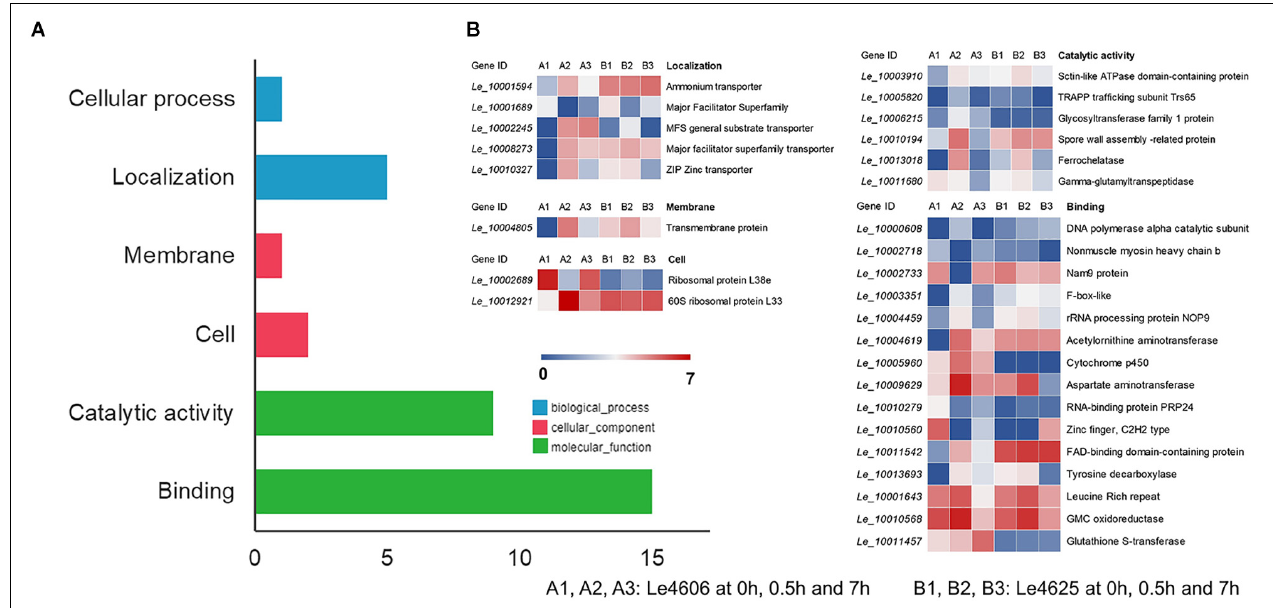
FIGURE 4 | GO classification and transcript abundance of DEGs in Le4606 after Cd exposure. (A) GO classifications of DEGs. (B) Heatmap of genes in different GO